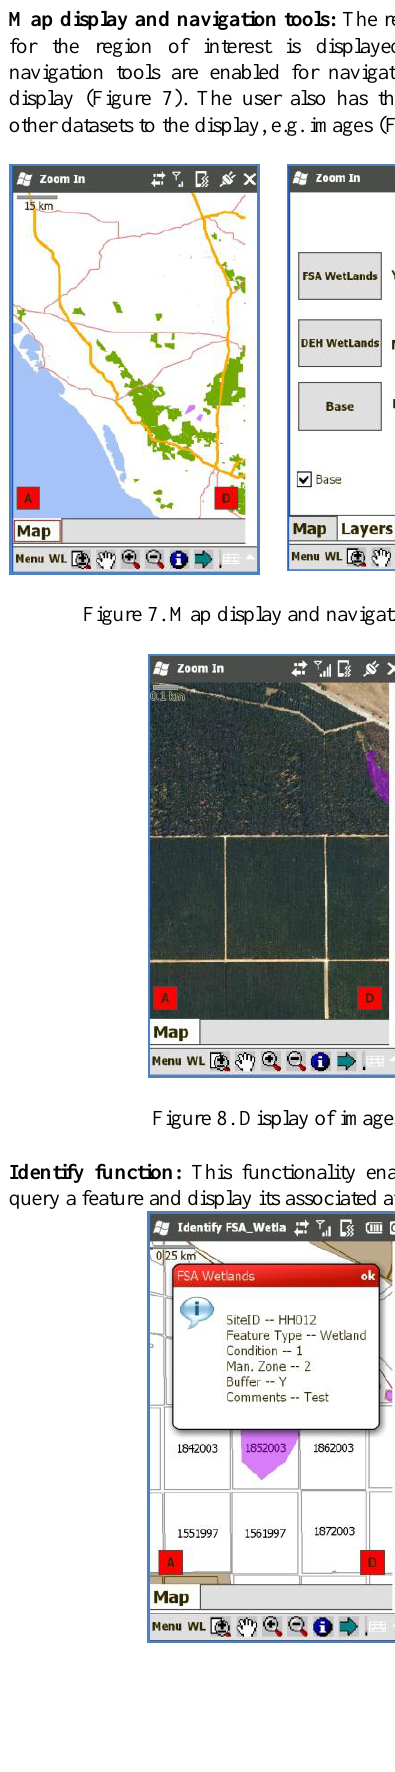
Figure 7. Identification of features